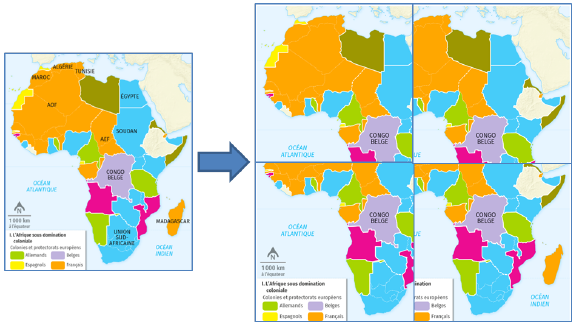
Figure 8: The dataset is augmented by cutting each map in four square images with overlaps.